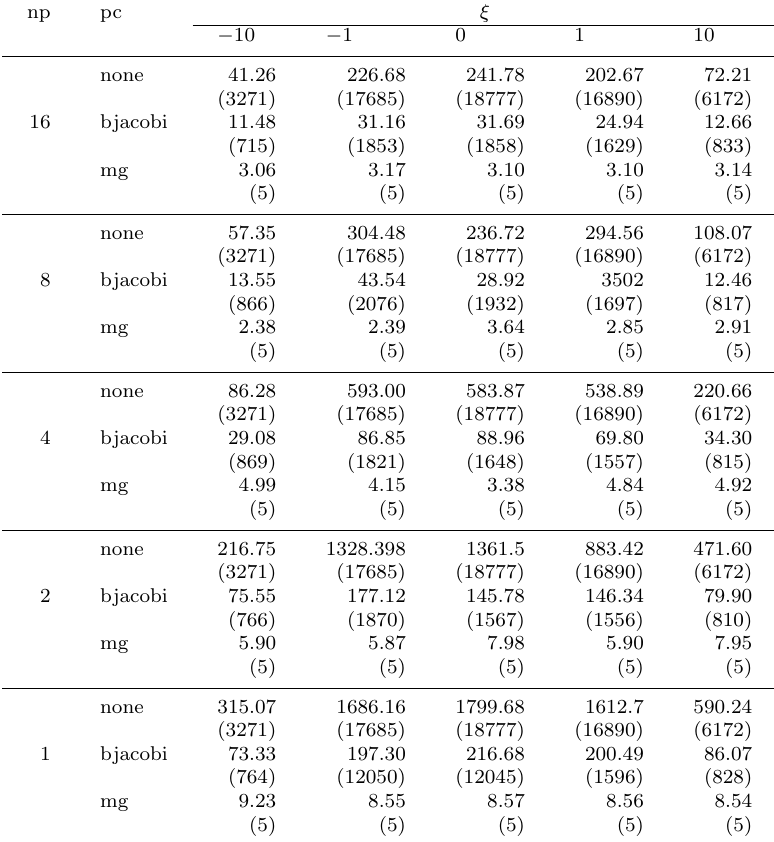
Table 4. Computation time in seconds (the number of iterations), np – number of processes, pc –